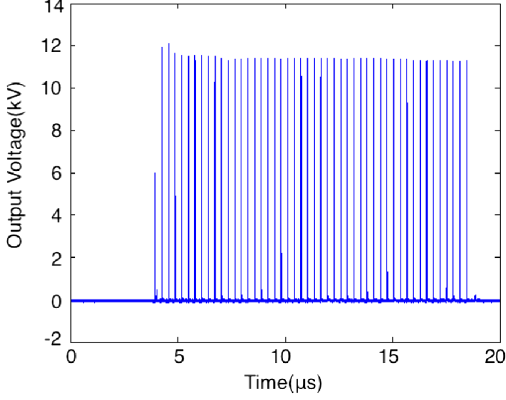
FIG. 8. Burst pulse waveforms of